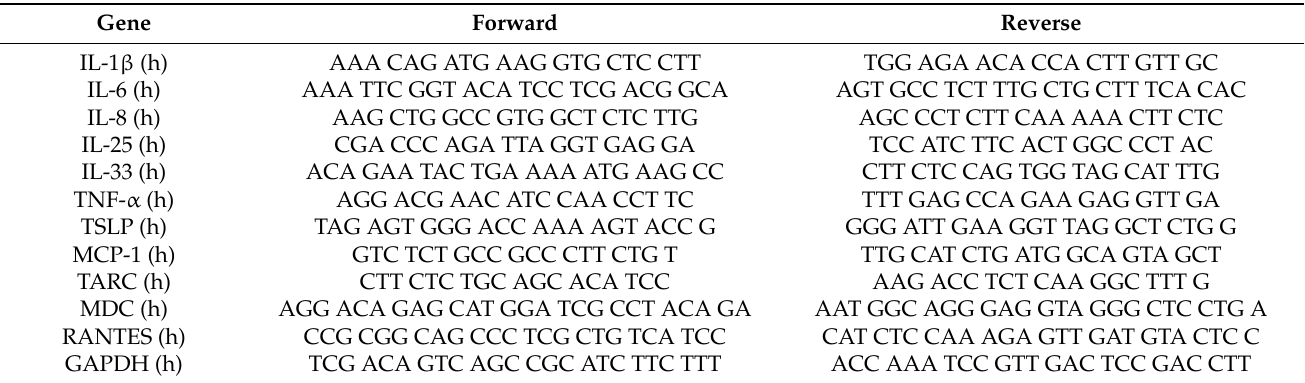
Table 2. Sequences of primers used in